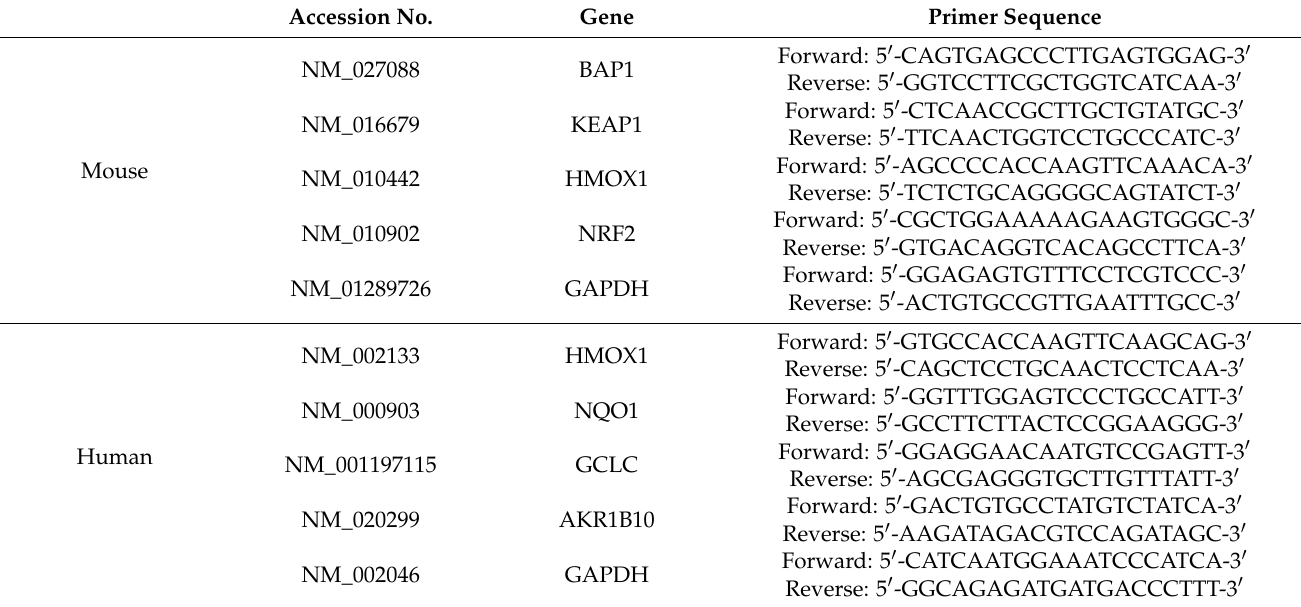
Table 1. List of real-time PCR